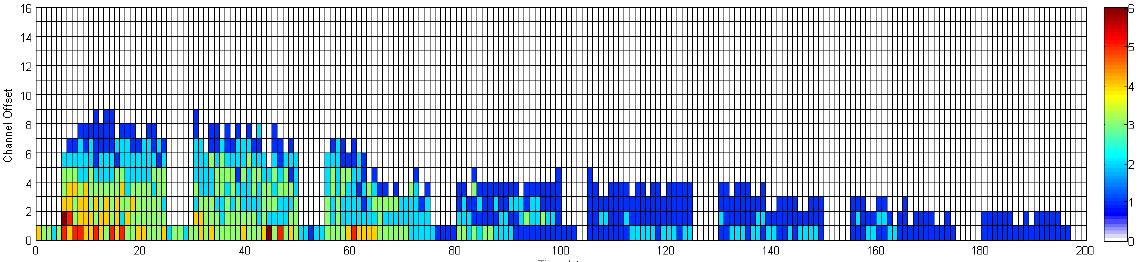
Figure A4. Communication schedule of D-MSR network with 19 nodes per one-hop neighborhood.